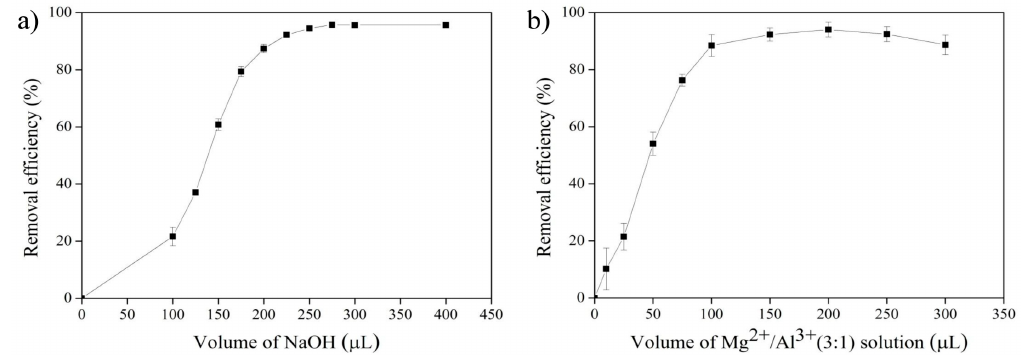
Figure 2. The effect of ( a ) the volume of 1 M NaOH and ( b ) the volume of mixed metal solution on the removal efficiency of TC in aqueous solution at an initial concentration of 30 mg L − 1 .